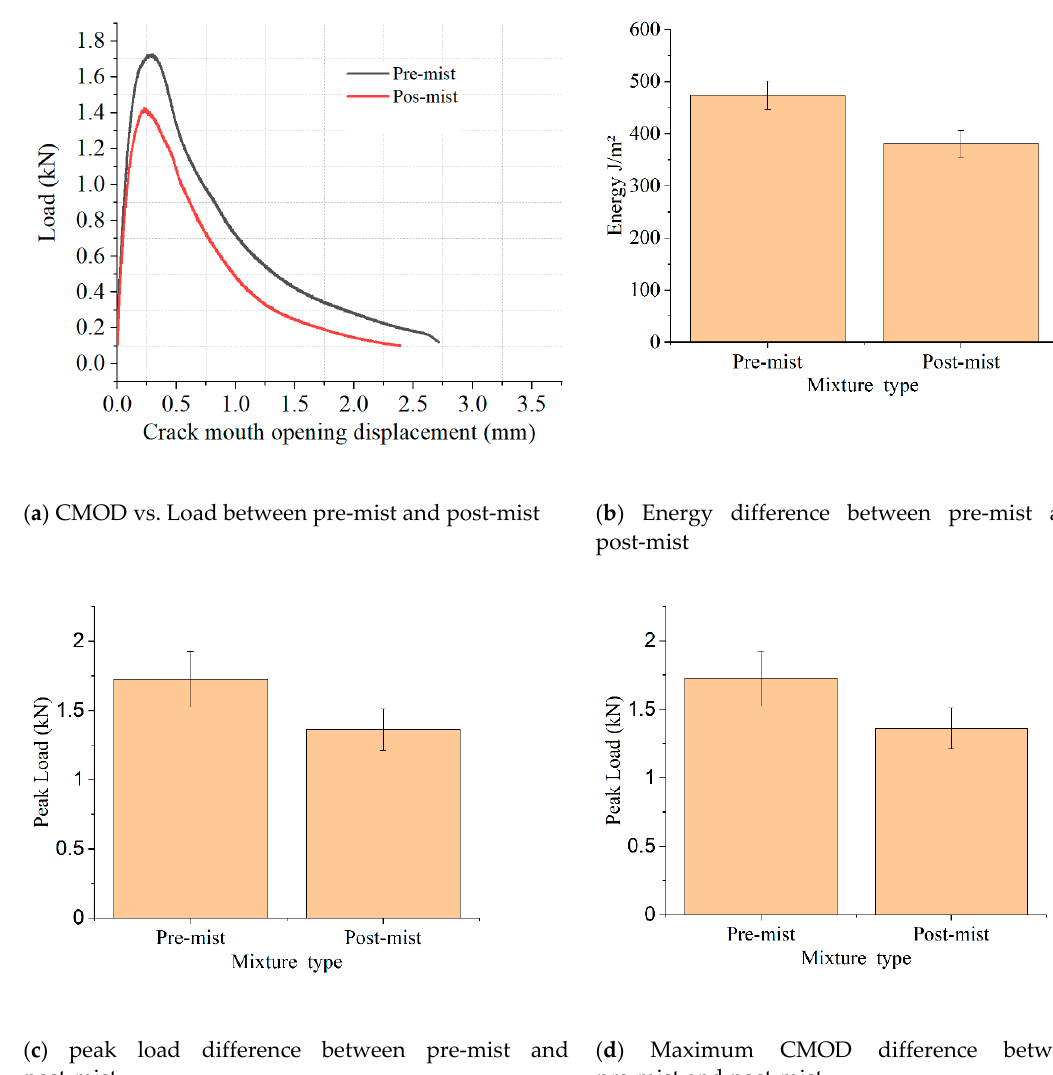
Figure 12. Low-temperature cracking resistance results of pre-mist and post-mist CIR asphalt mixture: ( a ) CMOD vs. Load between pre-mist and post-mist; ( b ) Energy difference between pre-mist and post-mist; ( c ) peak-load difference between pre-mist and post-mist; ( d ) Maximum CMOD difference between pre-mist and post-mist.